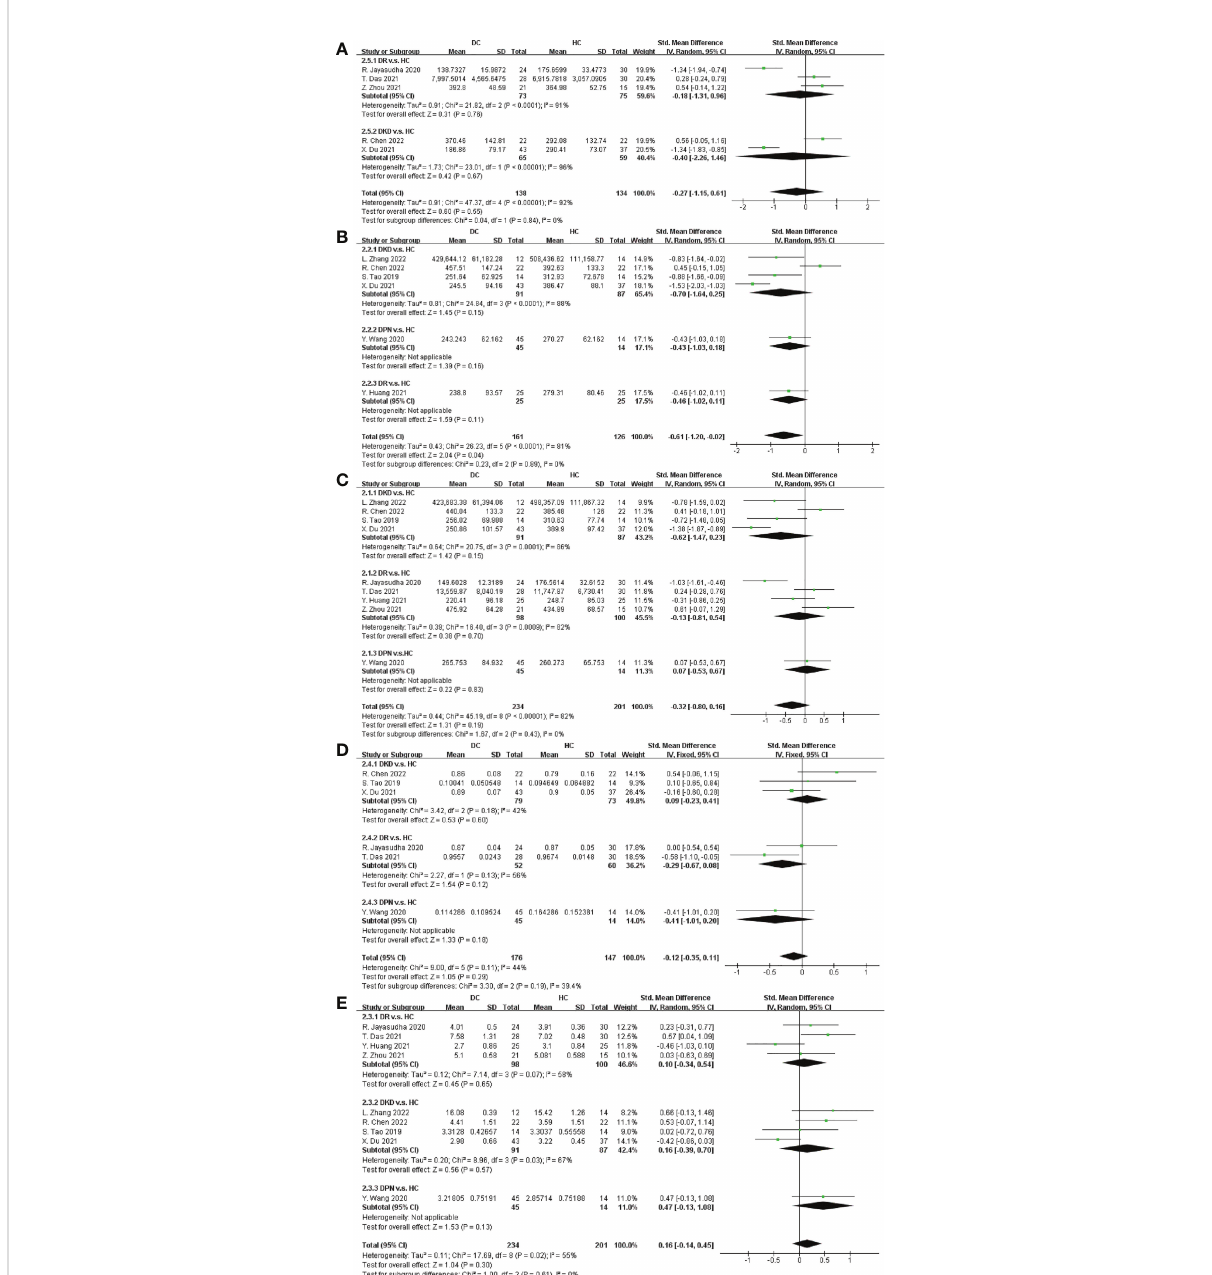
FIGURE 3 Forest plots of alpha diversity in DC v.s. HC. (A) OTUs; (B) ACE; (C) Chao1; (D) Simpson; (E)